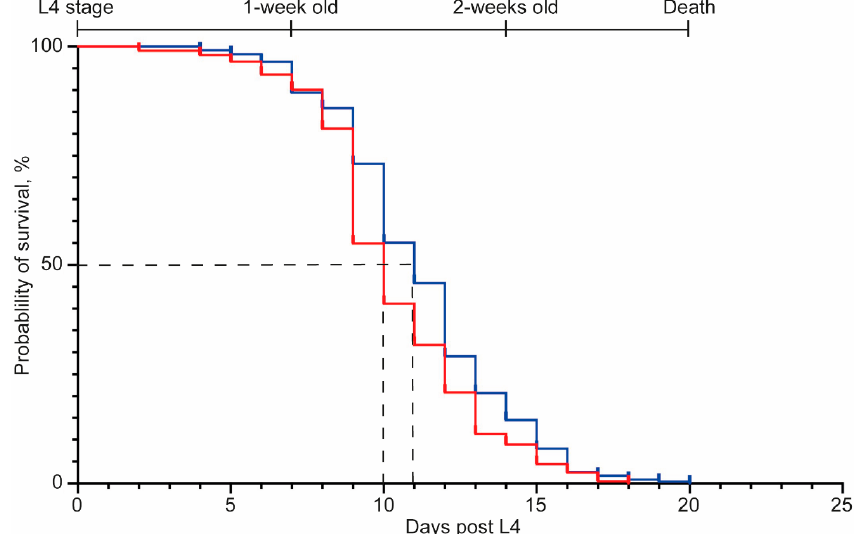
Figure 3. C. elegans that express the human α -synuclein have no difference in lifespan compared to control worms. Wild-type animals (strain, N2 ; red line) and those that express the human α -synuclein (strain, NL5901 ; blue line) were observed for survival on NGM in the presence of FUdR, a compound that prevents offspring from hatching. The life stages of nematodes are indicated along the top of the graph and the 50% survival point highlighted by a dashed line. Details of the mean and maximal lifespan are shown in Supplementary Table S1.